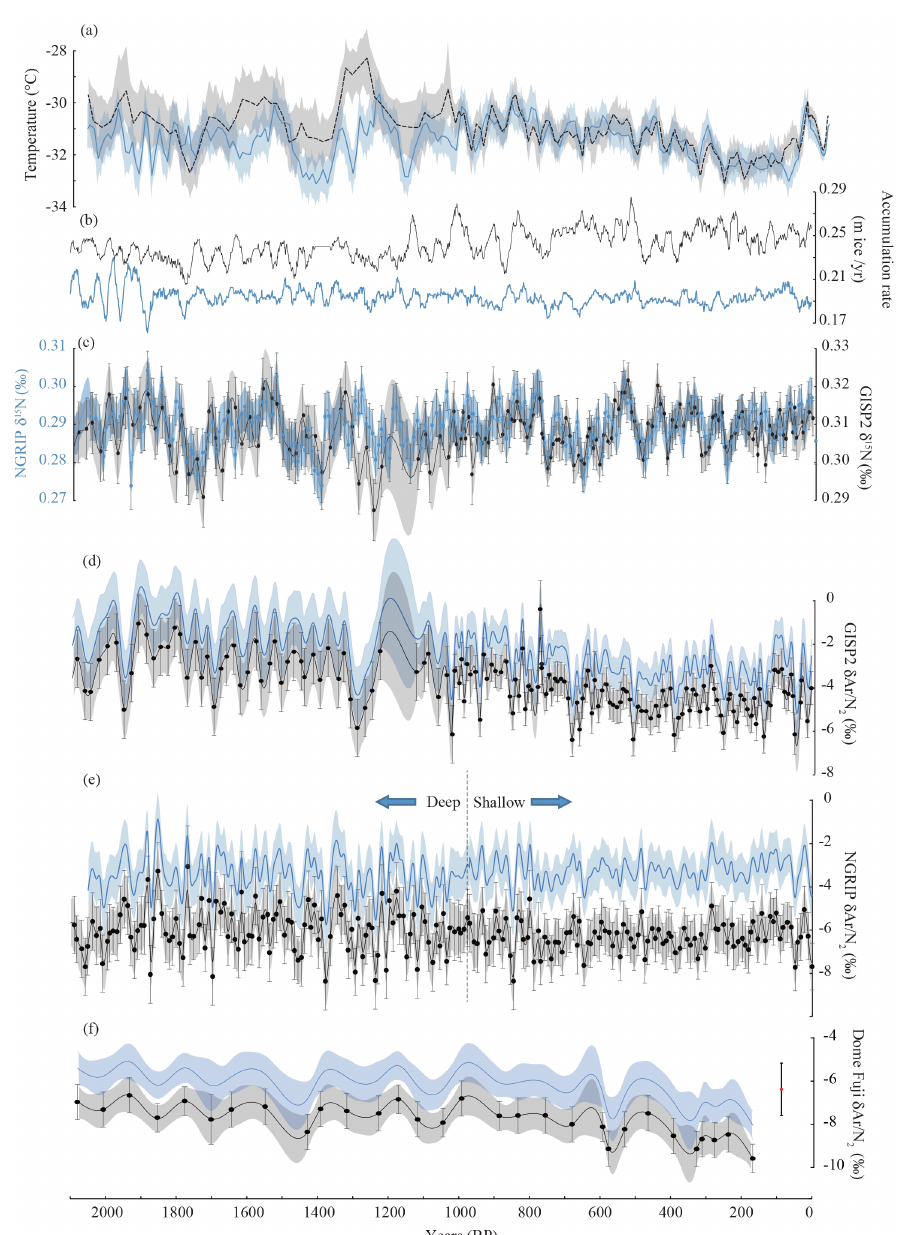
Figure 7. Surface temperatures, accumulation rates, δ 15 N, δ Ar / N 2 for GISP2, NGRIP, and Dome Fuji over the past 2100 years. (a) Surface temperatures for GISP2 (black) and NGRIP (blue) (Kobashi et al., 2015). (b) Accumulation rates in 21-year RMs for GISP2 (black: Alley et al., 1997; Cuffey and Clow, 1997) and NGRIP (blue: Gkinis et al., 2014). (c) Raw δ 15 N and spline for NGRIP and GISP2 (Kobashi et al., 2010, 2015). (d – f) δ Ar / N 2 and the values corrected for the post-coring fractionation for GISP2, NGRIP, and Dome Fuji. Blue and black lines are the raw and corrected values for the post-coring fractionations, respectively. A red point with error bounds (2 σ) indicates estimated δ Ar / N 2 for Dome Fuji using Eq.